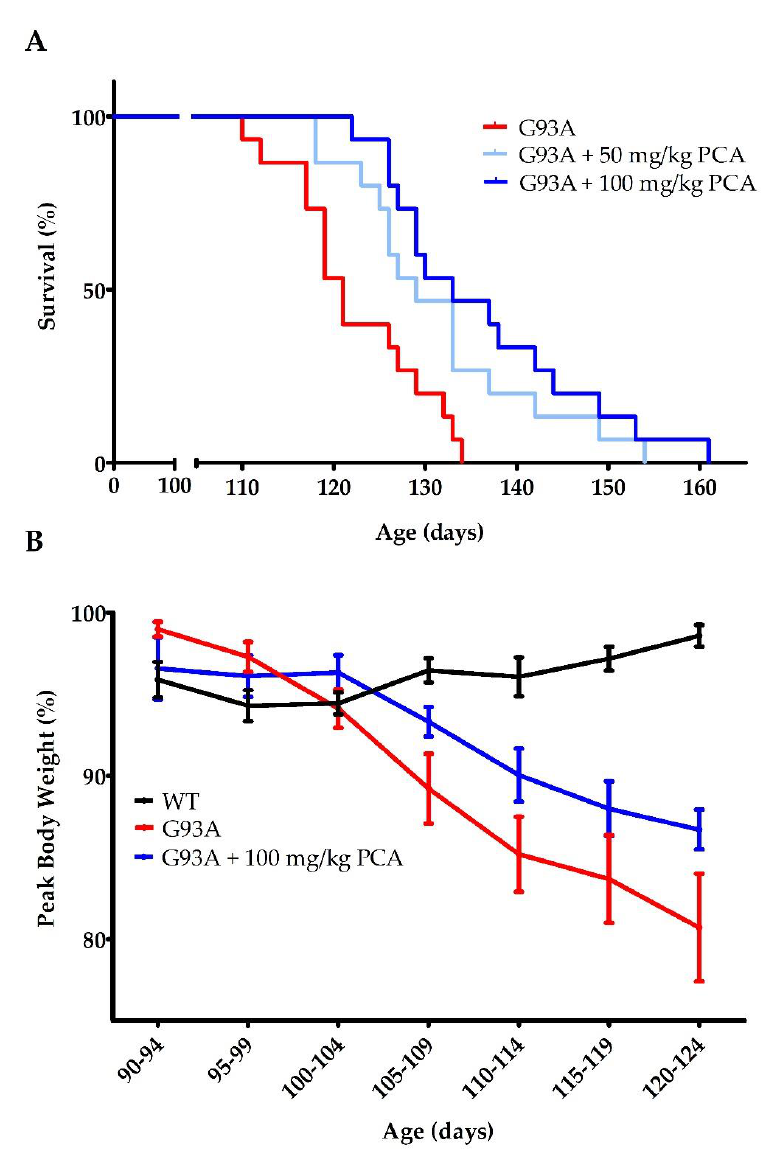
Figure 1. PCA treatment extends survival in the hSOD1 G93A mouse model of ALS. ( A ) Survival of hSOD1 G93A mice (untreated or treated with 50 or 100 mg / kg PCA) and wildtype mice (WT). Oral administration of either 50 or 100 mg / kg PCA beginning at disease onset (90 days of age) significantly extended median survival in hSOD1 G93A mice to 129 and 133 days, respectively, when compared to untreated hSOD1 G93A mice, which exhibited a median survival of 121 days. Curves are significantly di ff erent as determined by log-rank (Mantel–Cox) test ( p = 0.0025; n = 15 mice per group). ( B ) Body weight of hSOD1 G93A mice (untreated or treated with 100 mg / kg PCA) and WT mice. Body weight was assessed twice per week and is expressed as the percent of peak body weight at each time point. Data are displayed as the mean ± SEM with n = 15 mice for each group.